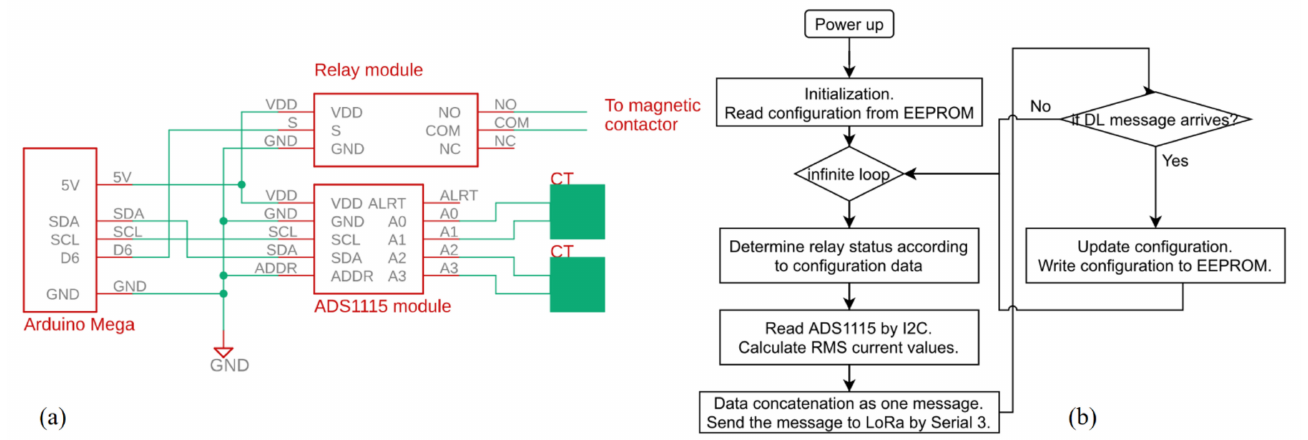
Figure 5. ( a ) A partial schematic and ( b ) the program flowchart for the type C unit.